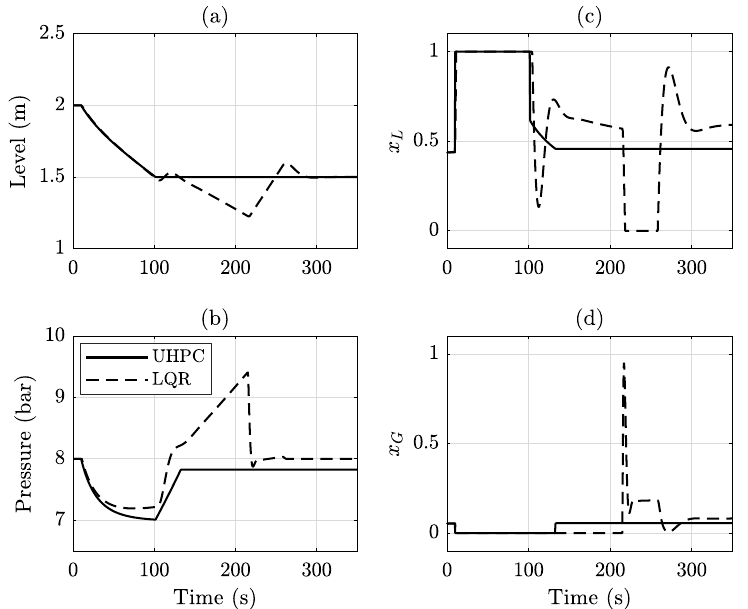
Figure 7. Simulation of the closed-loop system for step decrease in level reference. ( a , b ) the system outupts (level and pressure); ( c , d ) the respective control signals x L and x G .